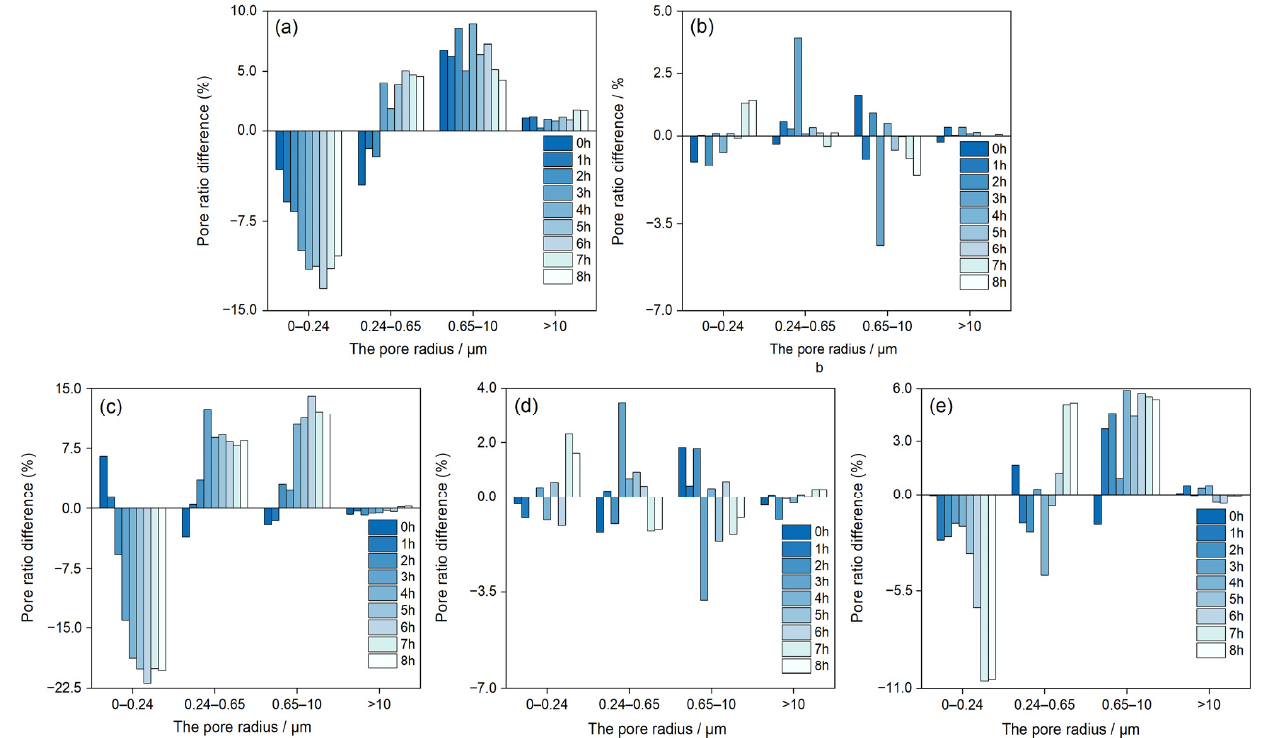
Figure 9. Comparative distribution of differences between different pore structures of samples leached with different concentrations of magnesium sulfate solutions: ( a ) difference of pore proportion between 0.0% and 3.0% solutions; ( b ) difference of pore proportion between 2.5% and 3.0% solutions; ( c ) difference of pore proportion between 3.5% and 3.0% solutions; ( d ) difference of pore proportion between 4.0% and 3.0% solutions; ( e ) difference of pore proportion between 4.5% and 3.0% solutions.